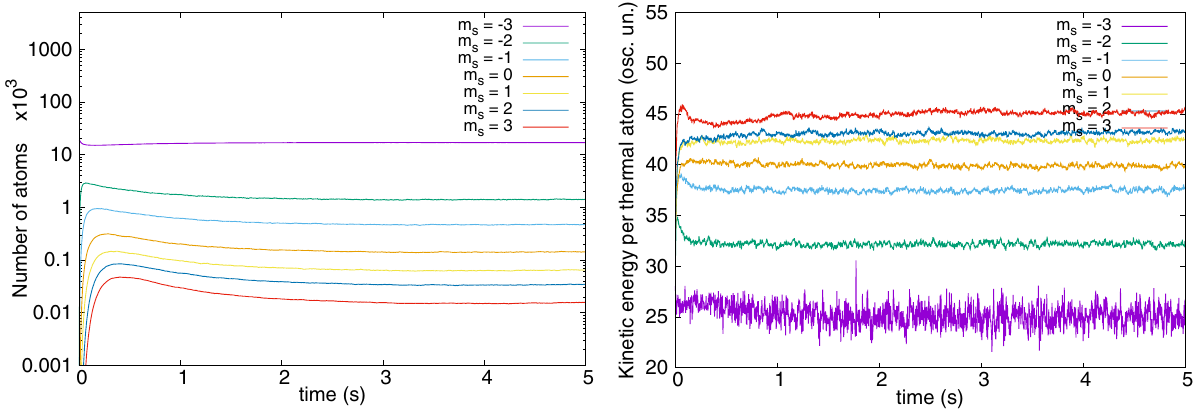
Figure 4. Populations (left) and kinetic energy per thermal atom (right, units of (cid:31) ω x ) as a function of time, for all Zeeman components in the 52 Cr simulations. A single long cooling step is made, with the same parameters as in Fig. 1 (left) and as in Fig. 2